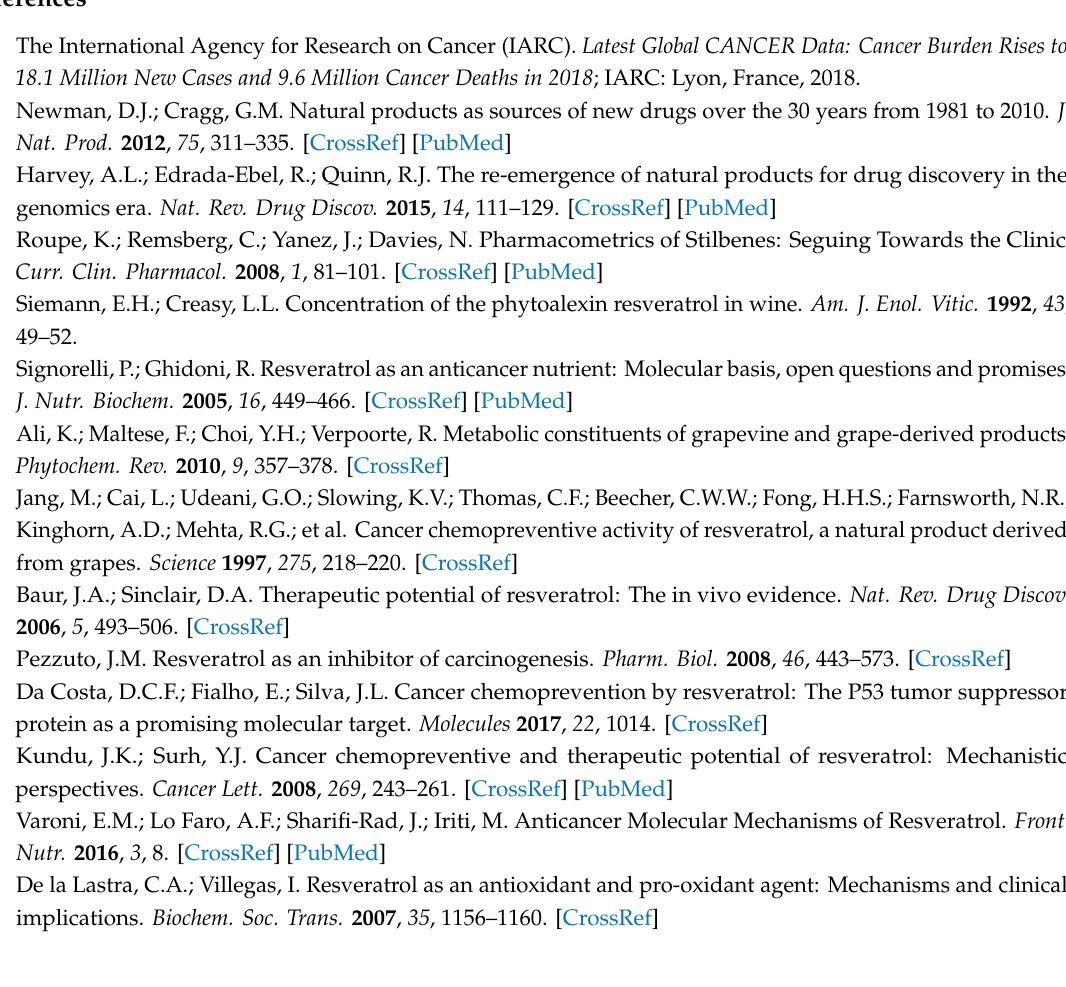
Supplementary Materials: The following are available online, Table S1: Bioactivity prediction (druglikeness*) of β -lapachone and its derivatives for specific biological activities; Table S2: Bioactivity prediction (druglikeness*) of resveratrol and its derivatives for specific biological activities; Table S3: Chemical and pharmacological properties of Lapachol, β -lapachone and derivatives; Table S4: Chemical and pharmacological properties of resveratrol and